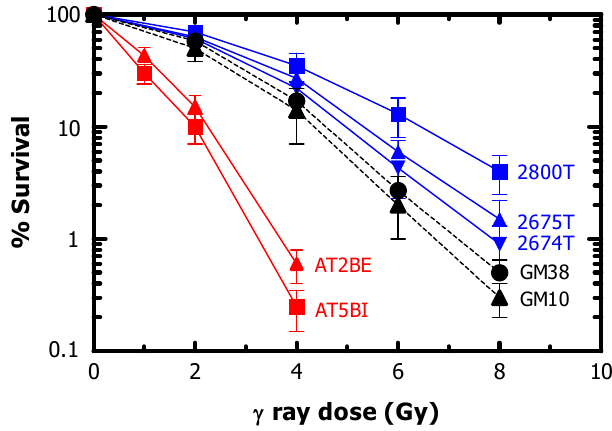
Figure 4. Clonogenic survival curves for human normal (GM10, GM38), ataxia telangiectasia (AT) (AT2BE, AT5BI) and Li-Fraumeni syndrome (LFS) (2800T, 2674T, 2675T) fibroblast strains after exposure to ionizing radiation. The results are reproduced from [119] with